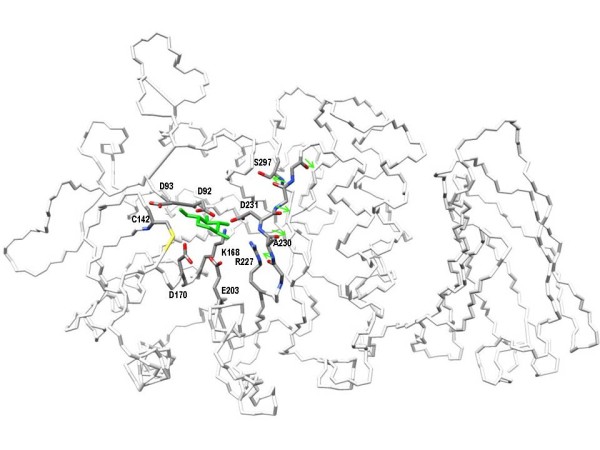
The active site of human lysosomal alpha-galactosidase. The active site of alpha-galactosidase is sketched as a wireframe coloured by atom type showing the side chains of residues which directly bind 1-deoxy-galactonojirimycin (D92, D93, D170, D231,E203, K168, R227), the side chains of C142, A230,S297 and the backbone of the peptide, ranging from 229 to 232, in poly-proline II helix conformation. Arrows run alongside carbonyl bonds. 1-deoxy-galactonojirimycin is coloured in green.